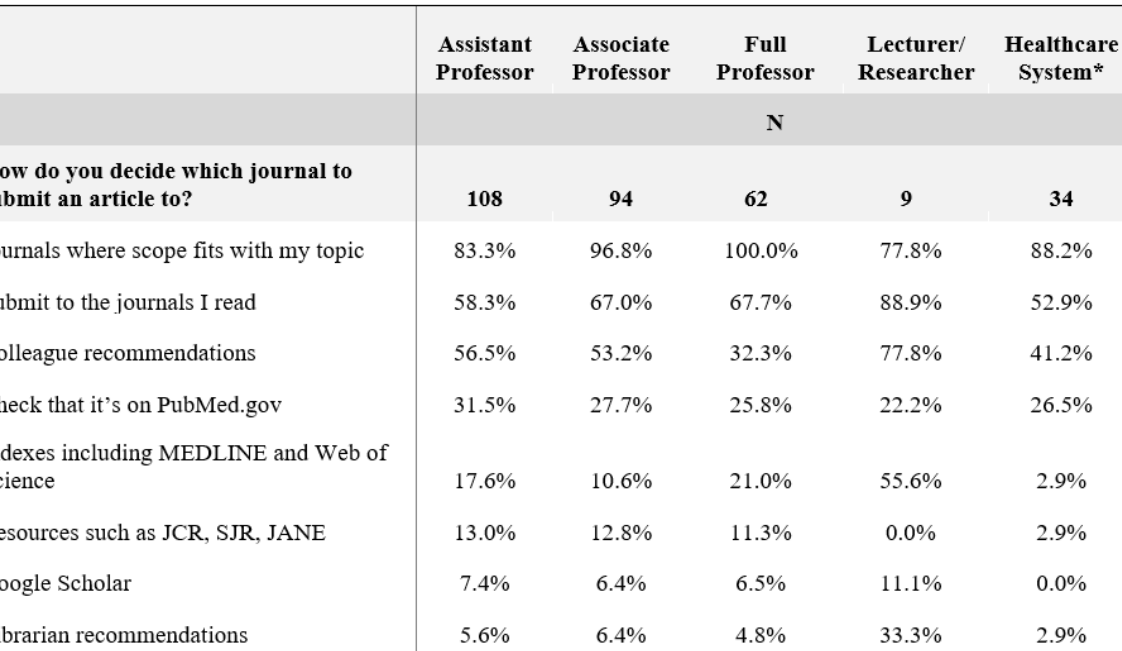
Table 2 How participants decided on journals for article submission, by position title